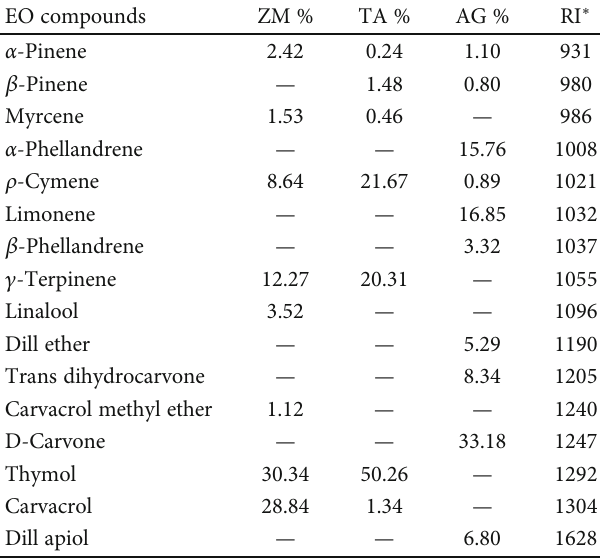
EO: essential oil; ZM: Zataria multi fl ora Boiss; TA: Trachyspermum ammi L.; AG: Anethum graveolens L; RI: the retention index of compounds on